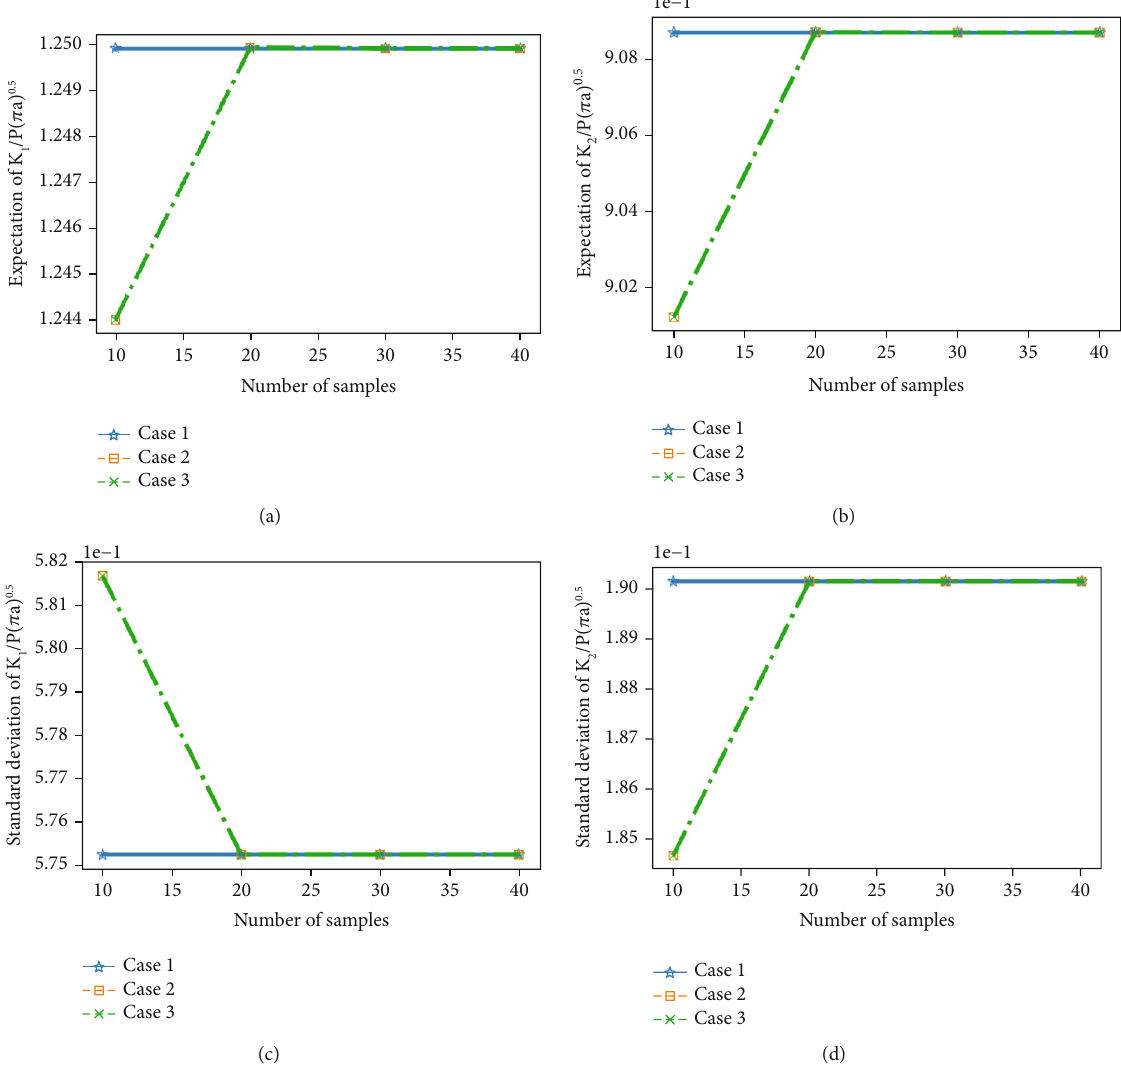
Figure 7: Expectations and standard deviation of di ff erent degrees of reduction: (a) expectations of the normalized SIFs K expectations of the normalized SIFs K / P ð π a Þ 0 : 5 ; (c) standard deviation of the normalized SIFs K 2 normalized SIFs K / P ð π a Þ 0 : 5 2